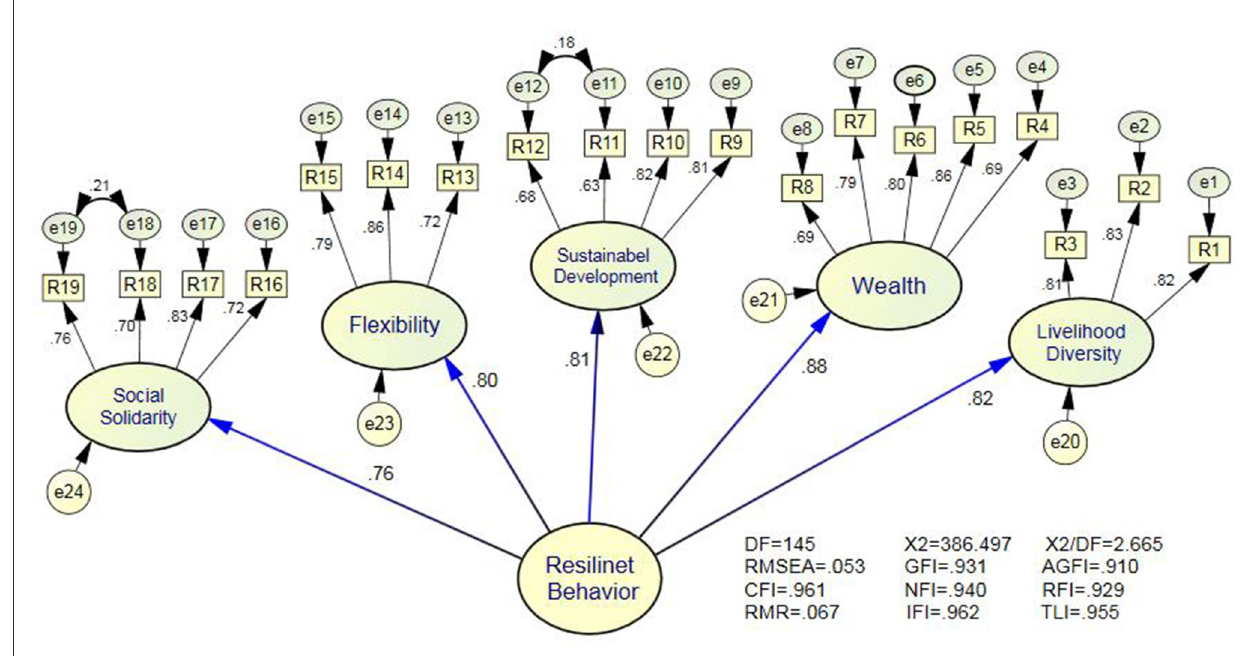
FIGURE2 The confirmatory model of the latent variable (structure) of resilience against climate change with standardized factor